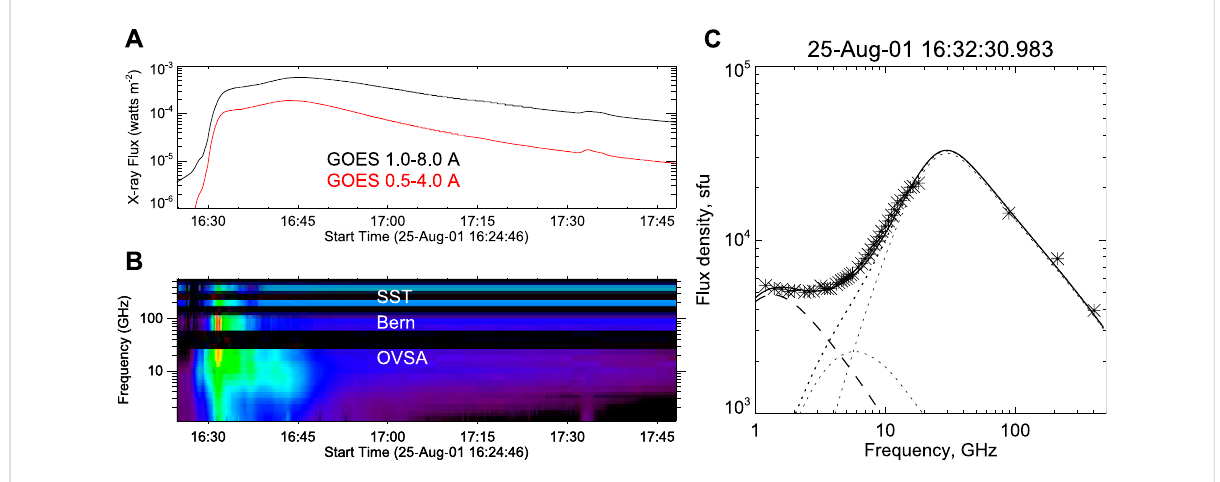
FIGURE 4 An example of a SOL 2001-08-25T16:23 fl are with, perhaps, the most broadband nonthermal radio emission. (A) GOES light curves shown for thecontext; (B) themulti-instrumentdynamicspectrumoftheat1 – 405 GHz; (C) themeasuredandmodelspectrumofthe fl areatthepeaktime16: 32:31UT. The model assumes E max =10 MeV. From Fleishman et al. (2017); reproduced by permission of the